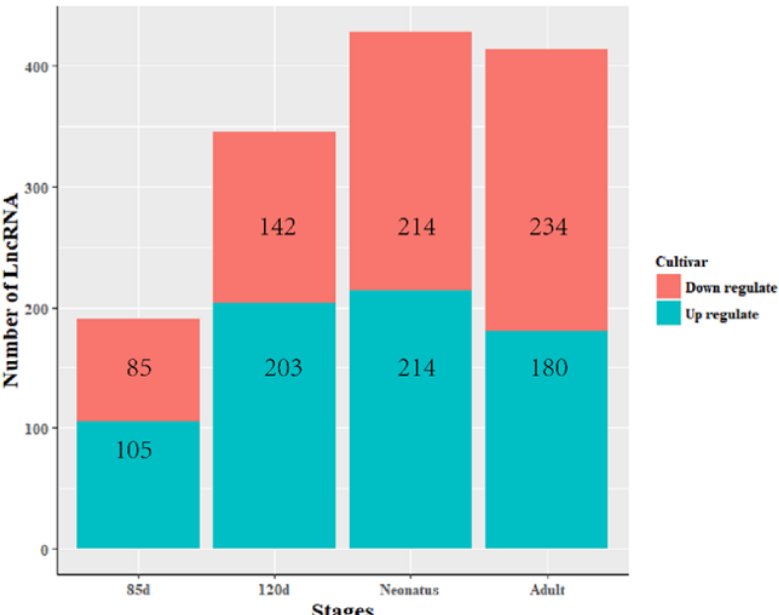
Figure 4. Numbers of lncRNAs differentially expressed between Texel and Ujumqin at four stages. The expression levels of lncRNA transcripts were estimated using FPKM. At the same developmental phase, the expression levels of lncRNA transcripts were compared between Texel and Ujumqin samples. Red represents down-regulated lncRNAs and blue represents up-regulated ones. On fetal day 85, 190 DEGs were found, including 85 down-regulated DEGs and 105 up-regulated DEGs. On fetal day 120, there were 345 DEGs, including 142 down-regulated DEGs and 203 up-regulated DEGs. In neonates, there were 428 DEGs, including 214 down-regulated DEGs and 214 up-regulated DEGs. Finally, in adults, there were 414 DEGs, including 234 down-regulated DEGs and 180 up-regulated DEGs. Overall, the numbers of down- and up-regulated DEGs generally increased with age.